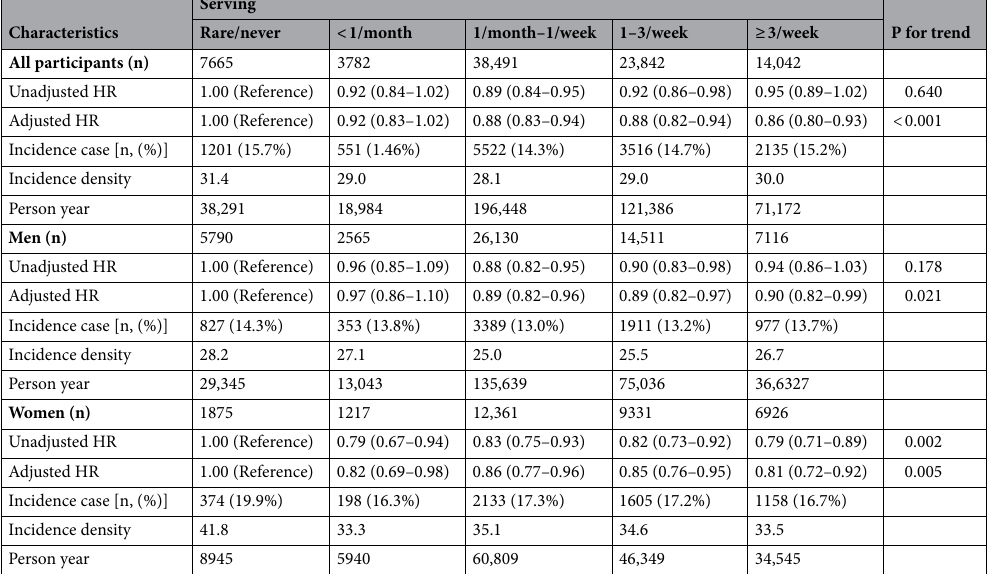
Table 2. Hazard ratio (HR) and 95% confidence intervals (CI) for depressive symptom (CESD ≥ 16) according to the mushroom consumption. Adjusting covariates: age, BMI, sex, alcohol intake, hypertension, diabetes, smoking, marital status, education, and total calorie intake (sex excluded in gender subgroup analysis). < 1/ month < one serving size/month, 1/month–1/week one serving size/month ≤ ~ < one serving size/week, 1–3/ week one serving size/week ≤ ~ < three serving sizes/week, ≥ 3/week ≥ three serving sizes/week. Adjusted HR multivariate-adjusted hazard ratio.